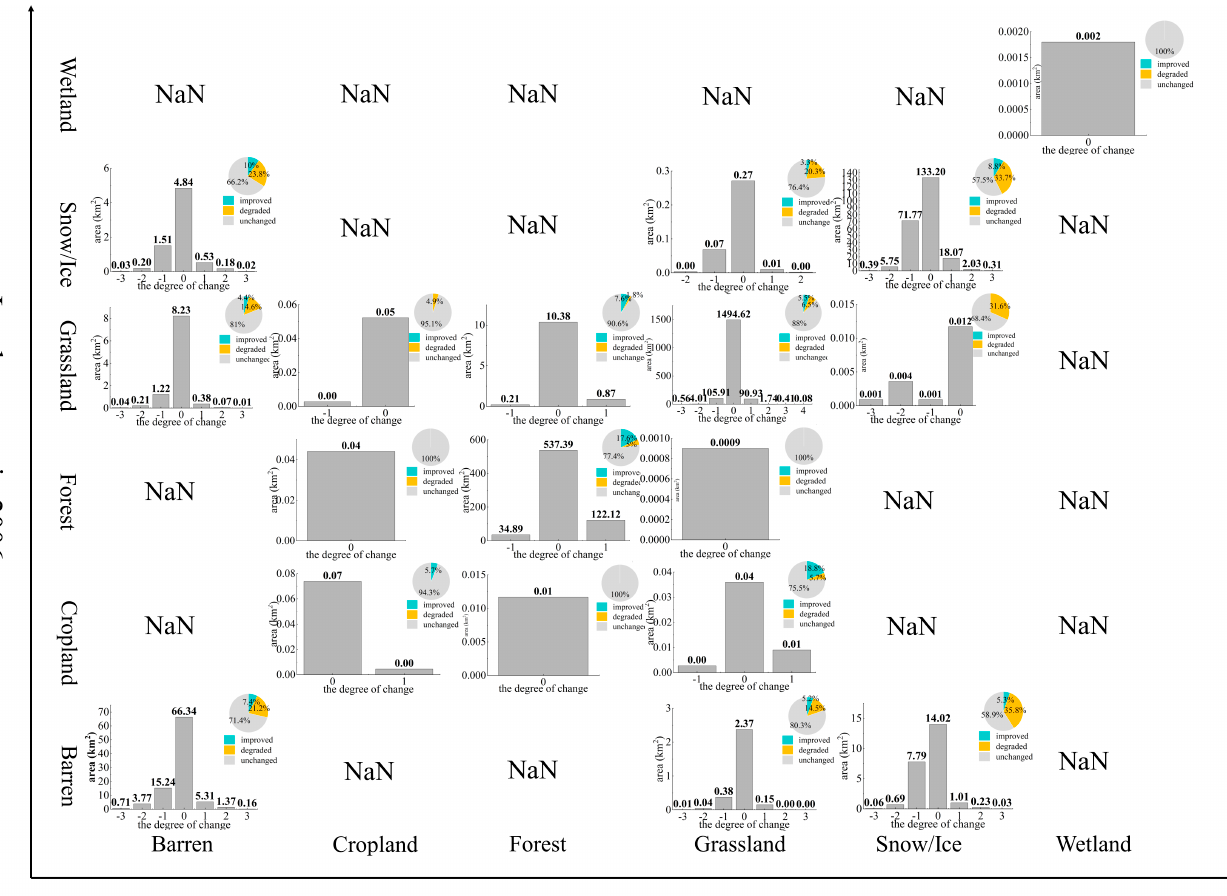
Figure 10. Statistics on the relationship between land use type change and ecological environment quality change from 2006 to 2011. NaN means there are no such observations. Taking the land use as barren in 2006 and as barren in 2011 as an example, we can see the shift area of the ecological class change caused by the barren–barren shift approach in the bar chart. At the same time, we can see the area proportion of ecological environment improvement or deterioration caused by the change in land use mode in the pie chart (bo tt om left corner of the fi gure).